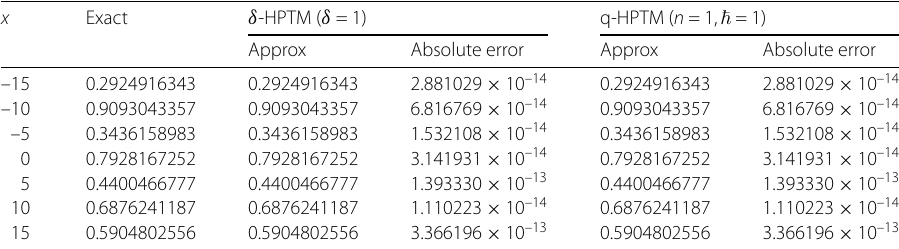
Table 5 The comparative study of Re[ W (3) ] solutions of δ -HPTM, q-HATM, and exact solution for